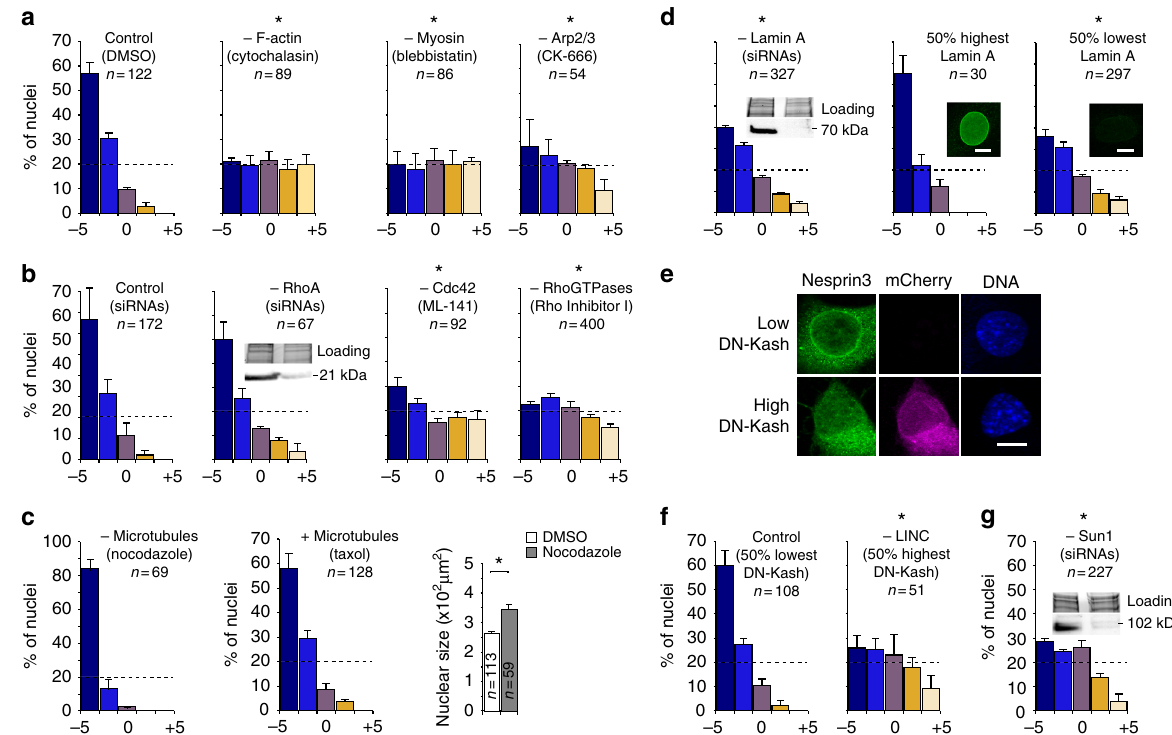
Fig. 5 Curvotaxis relies on actin dynamics ( a , b ), high Lamin A expression ( d ), and functional LINC complexes ( e , f , g ) but not microtubules ( c ). Impact of various drugs, siRNAs, or dominant negative construct (DN-Kash) overexpression on height distribution of mouse mesenchymal stem cells 24 h after adhesion on 3D sinusoidal surfaces. Western blots with total protein input are shown as controls for siRNA ef fi ciency (RhoA in b , Lamin A in d , and Sun1 in g ). *Signi fi cantly different from control using Student ’ s t -test with P value < 0.05. Error bars represent the standard error of the mean number of cells observed within a given height interval in three independent experiments. Scale bars: 5 µ